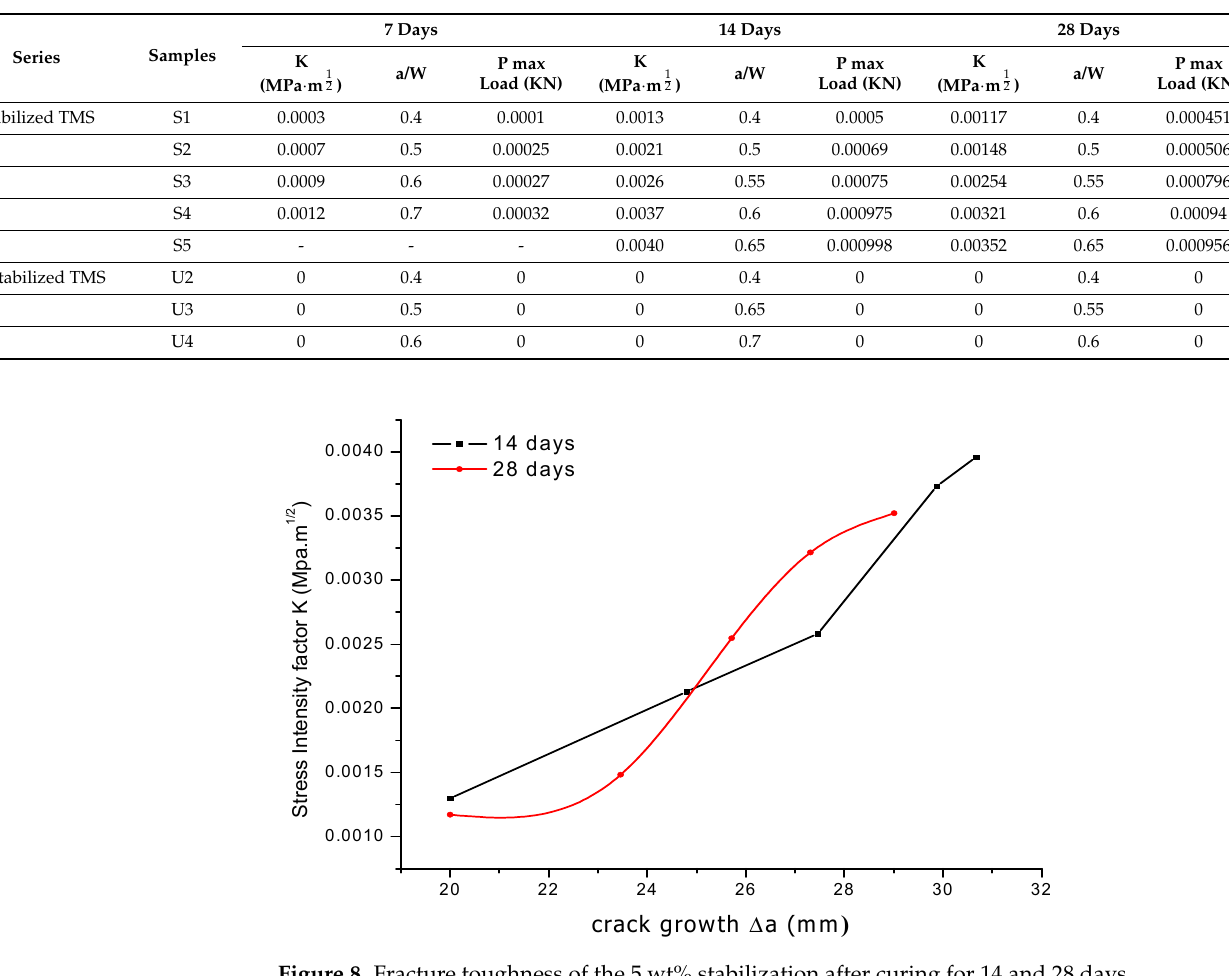
Figure 7. Flexural strength of the various samples with 5, 10, 15 and 20% stabilizations designated as